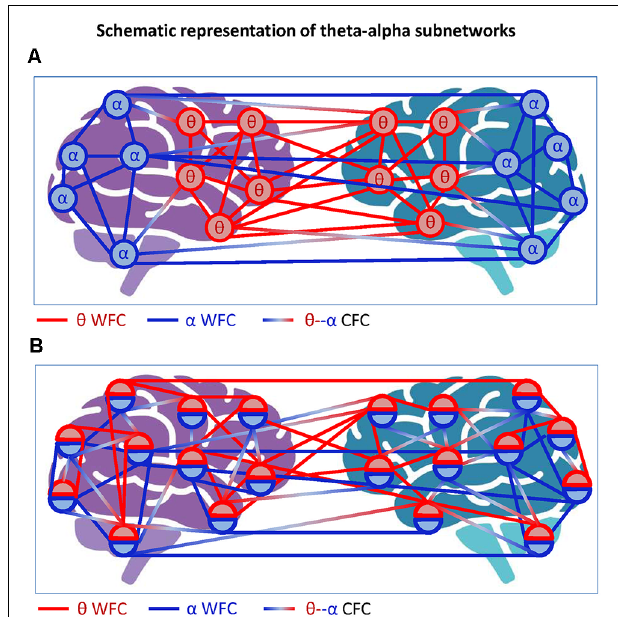
FIGURE 5 | Schematic representation of theta-alpha subnetworks. (A) Theta-alpha subnetwork as two hyper-brain modules oscillating at different frequencies. The two hyper-brain modules oscillating at different frequencies ( θ and α ) are coded by colors (blue and red). The coupling within the modules is given by WFC and the coupling between the modules by CFC. (B) Theta-alpha subnetwork with nodes oscillating at two different frequencies each. The two hyper-brain modules oscillating at different frequencies ( θ and α ), also coded in blue and red, are distributed across two brains, whereby each node belongs to both modules. The coupling within the modules is given by WFC and the coupling between the modules by